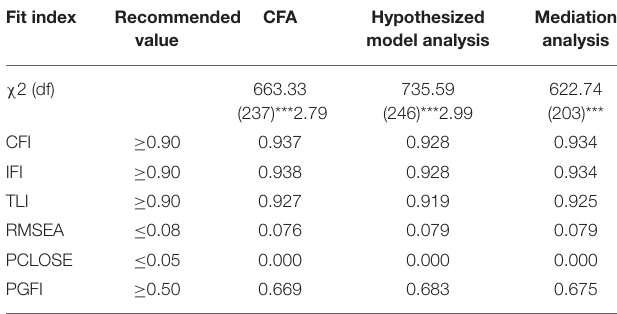
TABLE 2 | Fit indices of measurement and structural